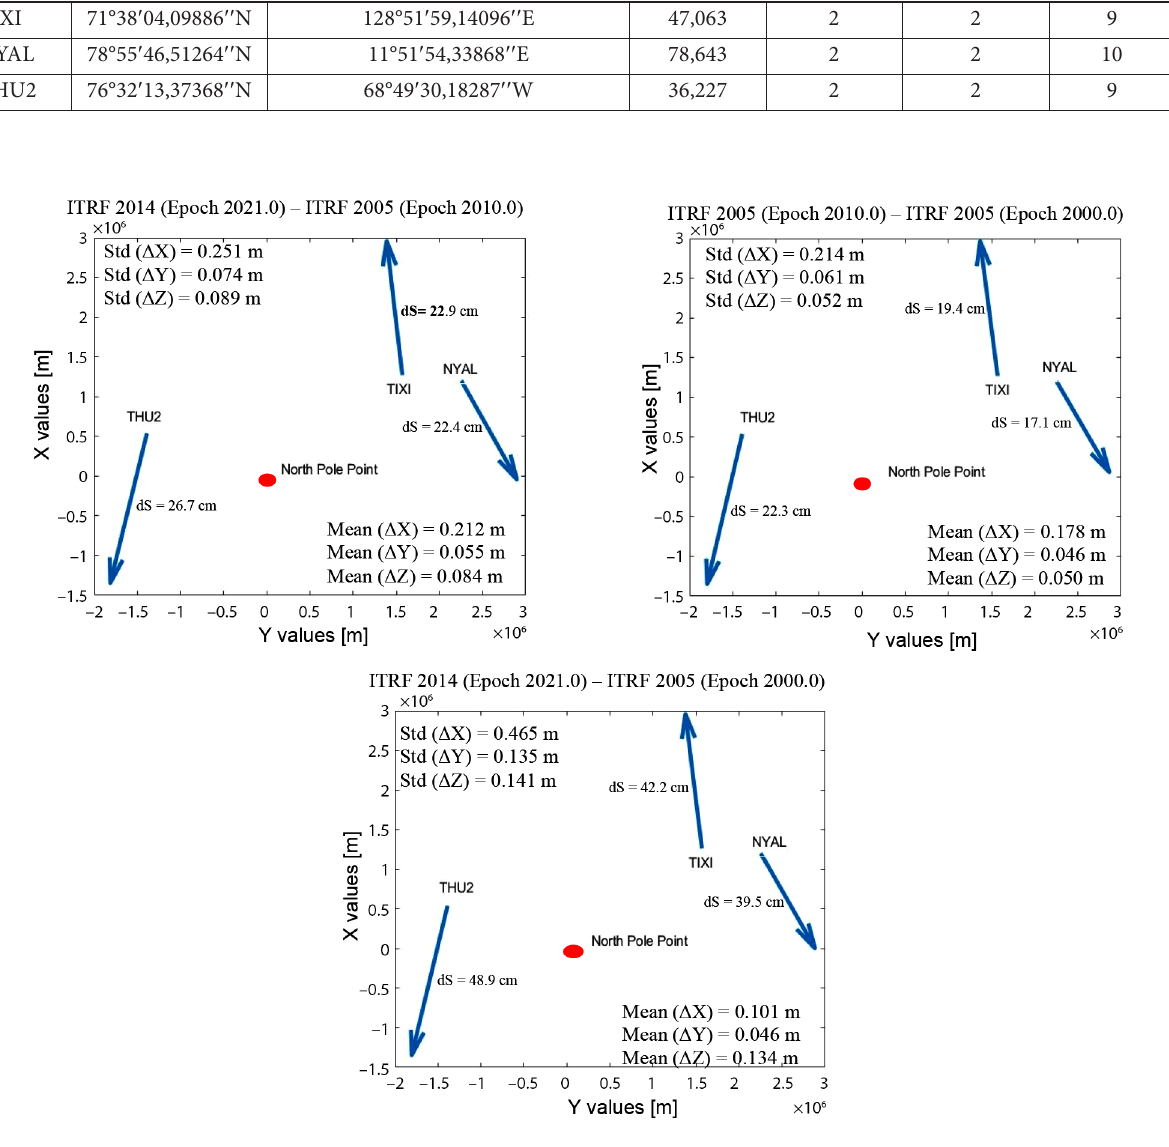
Figure 6. Horizontal displacement vectors (WGS 84 coordinate system) for three IGS points (North Pole Region) among